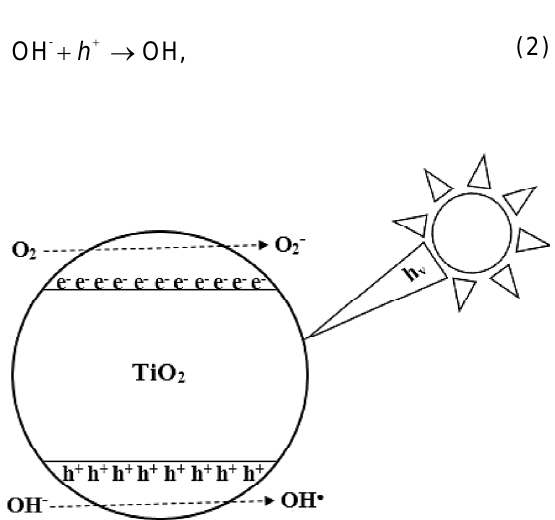
Fig. 7. Schematic diagram of photo-catalysis activ- ity of